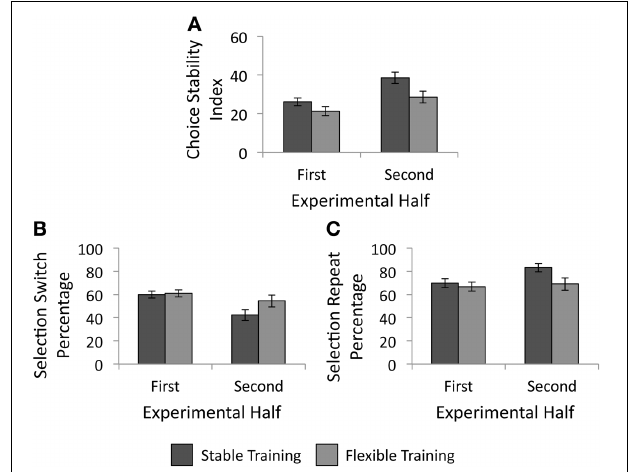
FIGURE 4 | Individual differences in trait impulsivity and selection behavior. (A) Relationship between individual differences in trait impulsivity and the percentage of object selection switches following an unrewarded selection during test. (B) Relationship between individual differences in trait impulsivity and the percentage of object selection repeats following a rewarded selection during test. (C) Relationship between individual differences in trait impulsivity and choice stability index during test. Each line denotes the best-fit linear regression equation when collapsing across training groups.